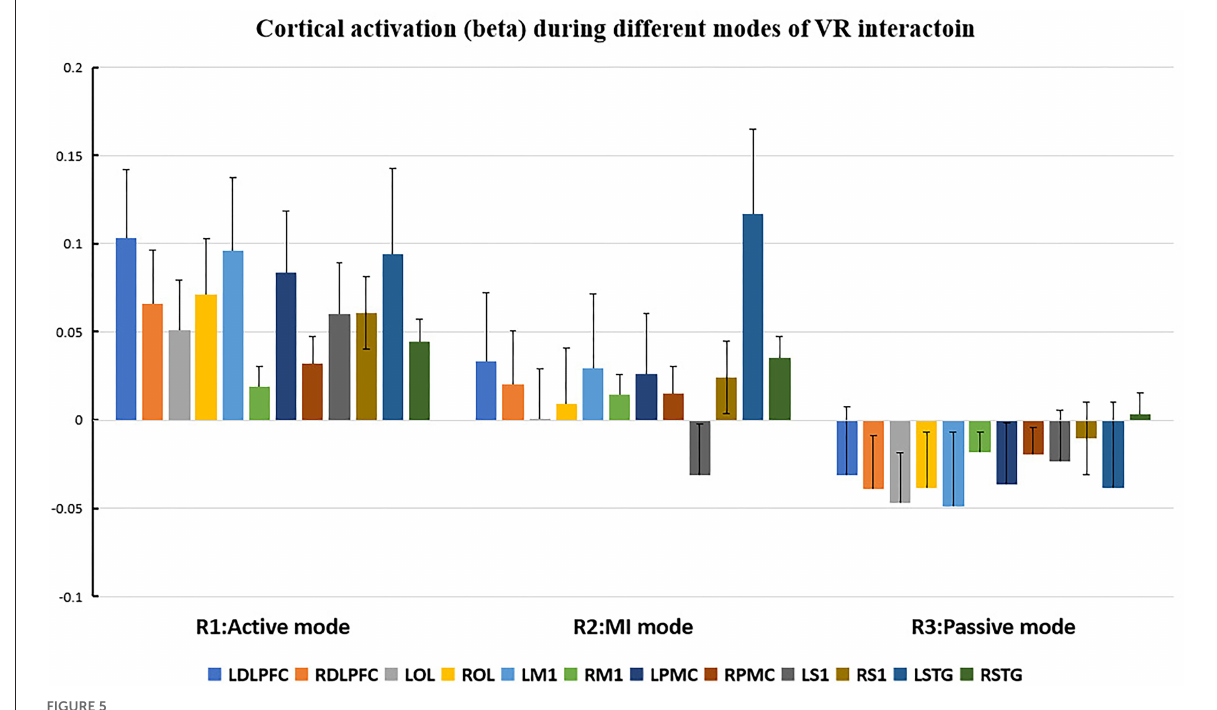
FIGURE5 Cortical activation ( β value) during different modes of virtual reality (VR) interaction. LDLPFC, left dorsal–lateral prefrontal cortex; RDLPFC: right dorsal–lateral prefrontal cortex; LOL, left occipital lobe; ROL, right occipital lobe; LM1, left primary motor cortex; RM1, right primary